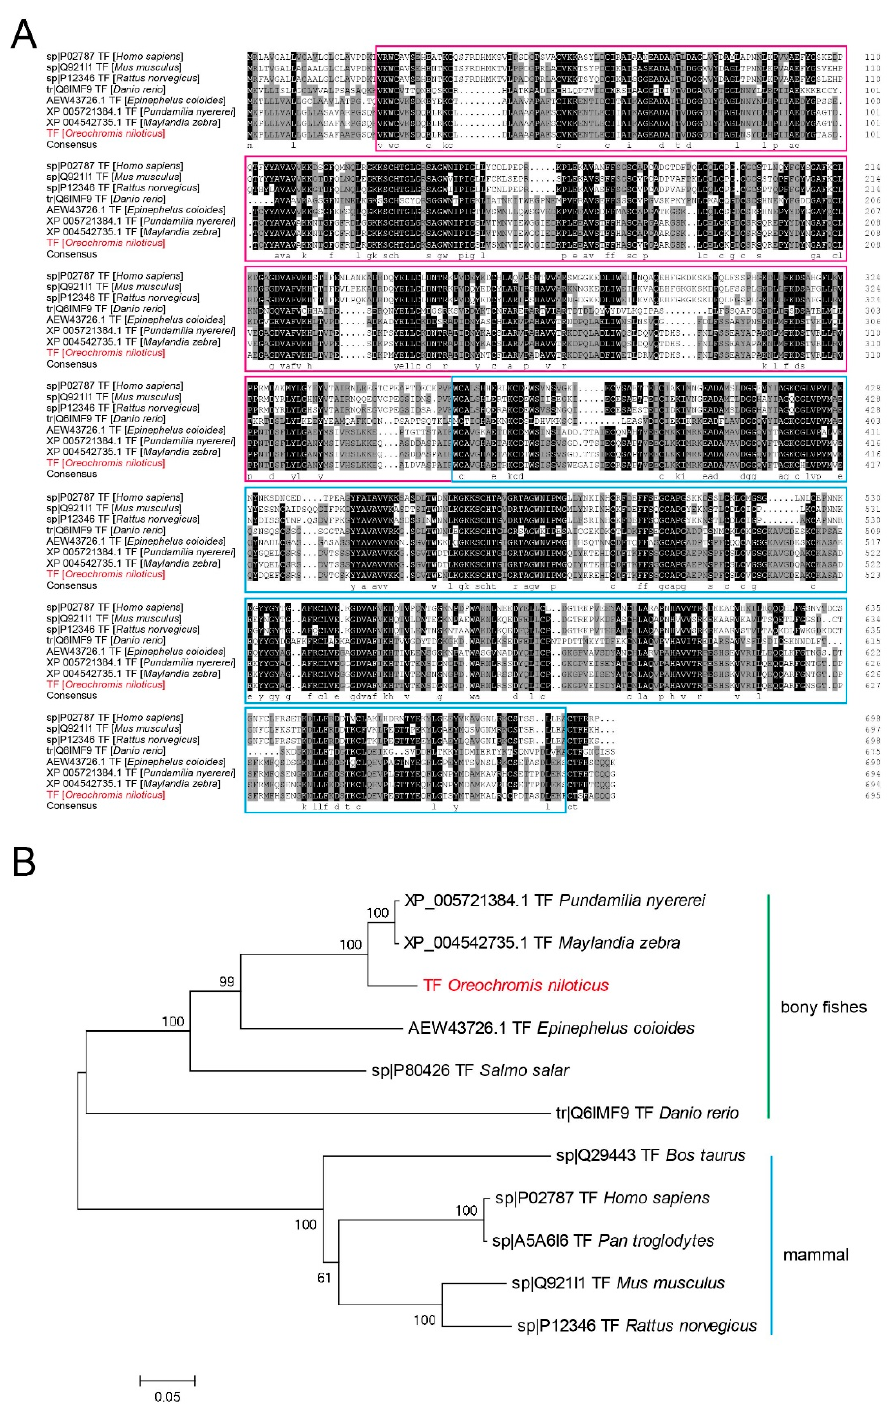
Figure 3. ( A ) TF multiple sequence alignment from different species. The TR_FER domains are indicated by a solid pink and a solid blue box. On-TF has a red highlight. ( B ) TF’s phylogenetic tree was created using the MEGA 6 software. On-TF is highlighted in red. Note: Consensus residues are in black. Residues that are ≥ 75% identical amongst aligned sequences are in grey.